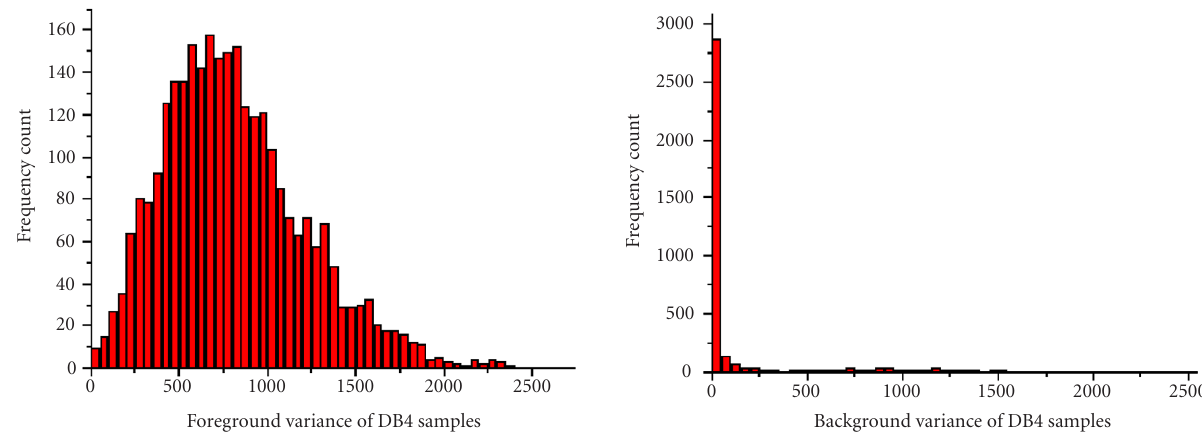
Figure 18: The block variance Var of the samples. The horizontal coordinate represents the value of the block variance while the vertical coordinate represents the frequency count of the